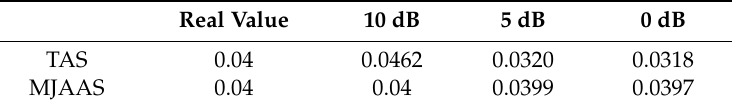
Table 3. The estimated results of ω e corresponding to CM (rad/s).